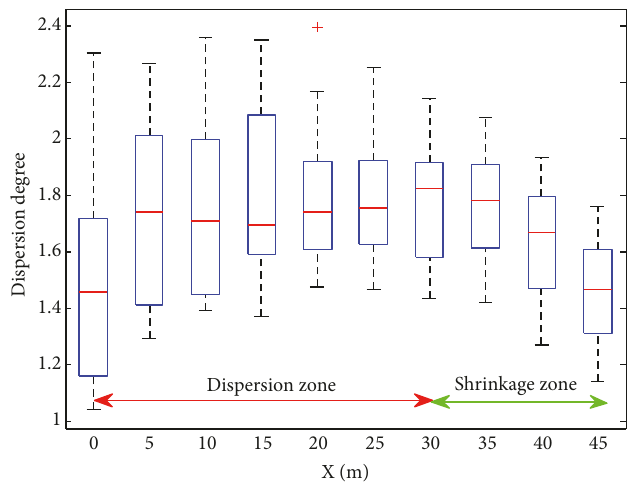
Figure 9: Boxplot of sectional dispersion degree at Changji-Moyu intersection.